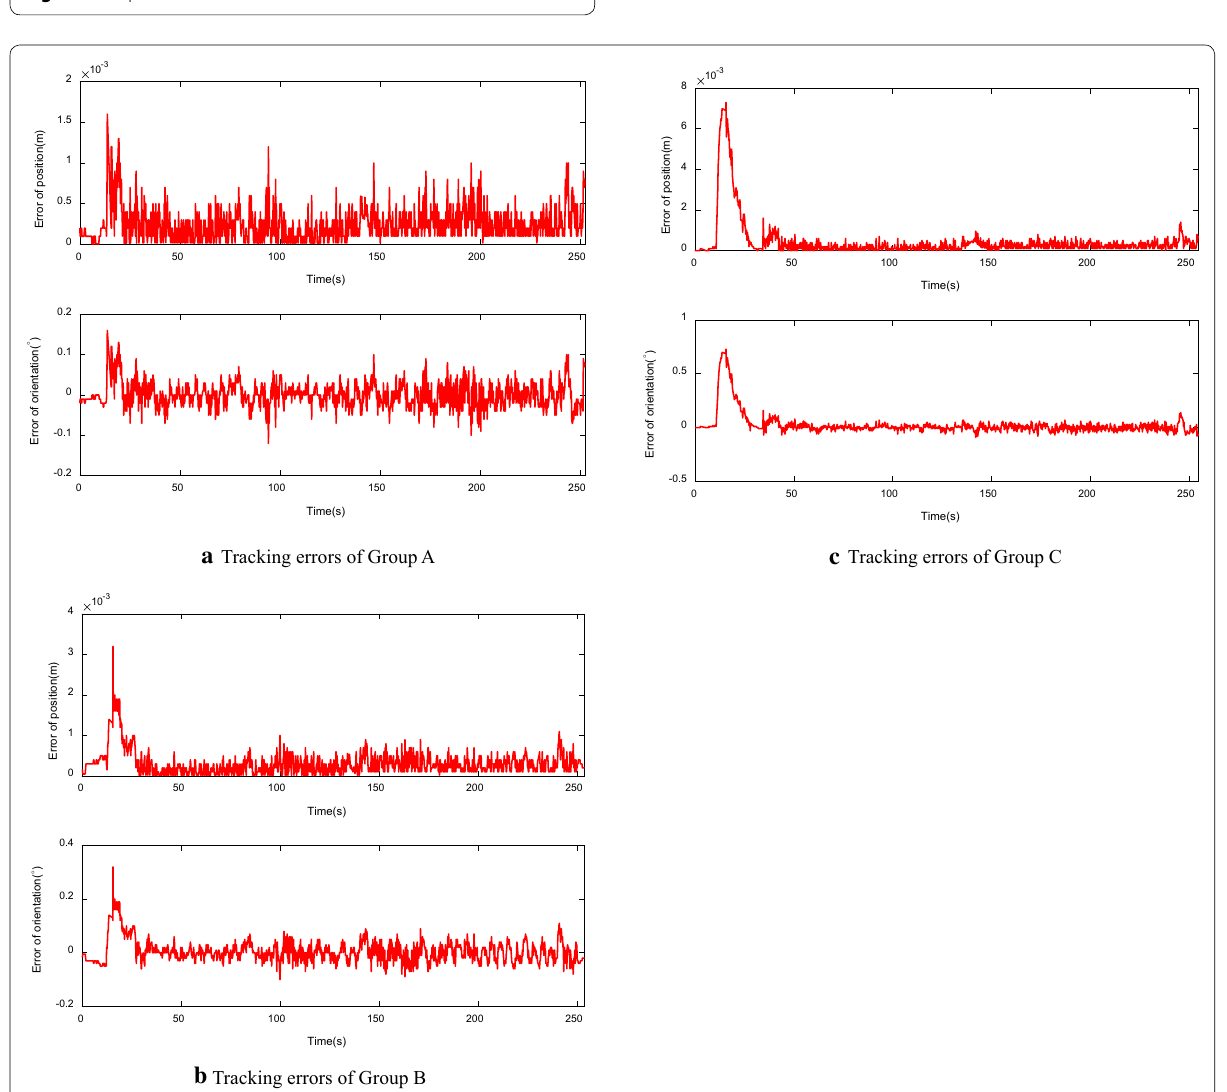
Figure 6 Experiment